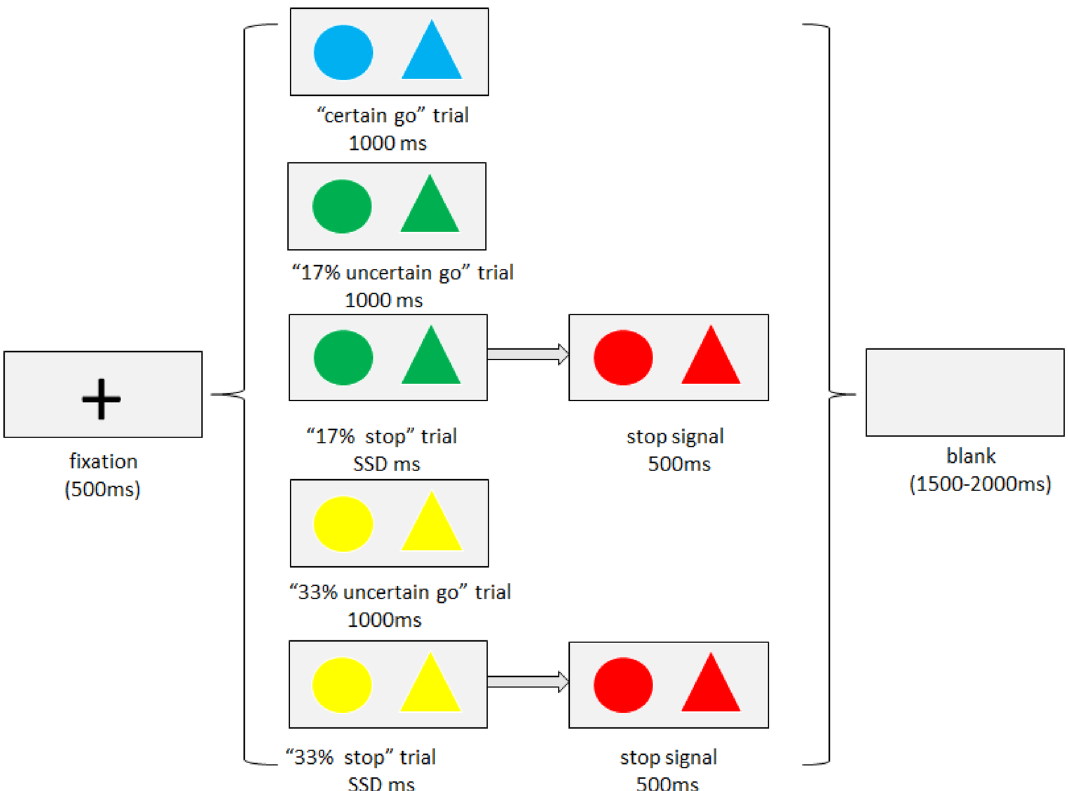
Figure 6. The adapted stop-signal task for the present study. 0%, 17% and 33% stop conditions appeared in a block form and the order of conditions was counterbalanced across sessions. In the 0% condition, only “certain go” trials are presented, the color of stimuli is blue. Each trial started with a black fixation presented for 500 ms, followed by a blue circle or triangle presented for 1000 ms, then a blank presented with randomly duration between 1500 and 2000 ms. Participants were instructed to press the “J” key in response to circles and “F” key to triangles as fast as possible. In the 17% stop condition, both “go” trials and “stop” trials are presented, the color of go stimuli is green, participants were instructed to make response to circles and triangles as 0% stop condition (“17% uncertain go” trials), however, for 17% probability, the color changed to red after a short delay (SSD), and subjects were required to withhold the response (“17% stop” trials). The SSD started was initially at 250 ms and varied from one stop trial to the next based on a staircase procedure. The 33% stop condition